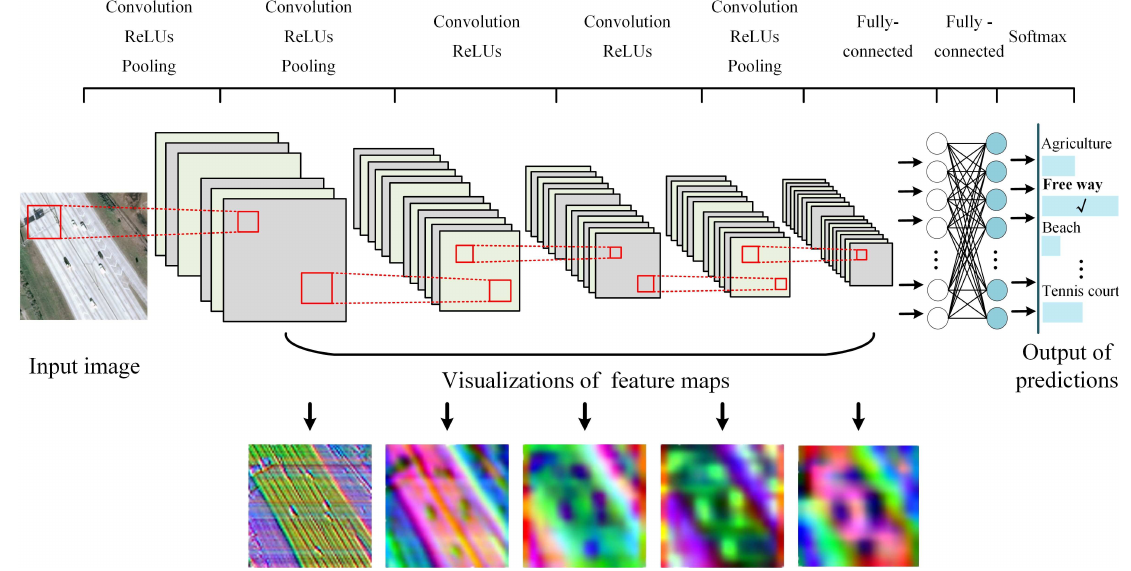
Figure 1. Architecture of